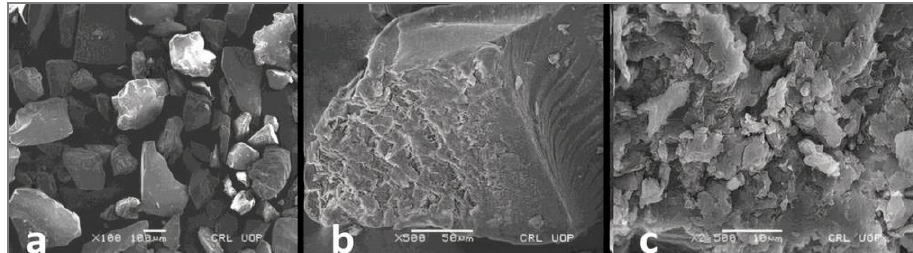
structure. The crystallinity index was 35.71%. Almond gum and Prunus domestica gum